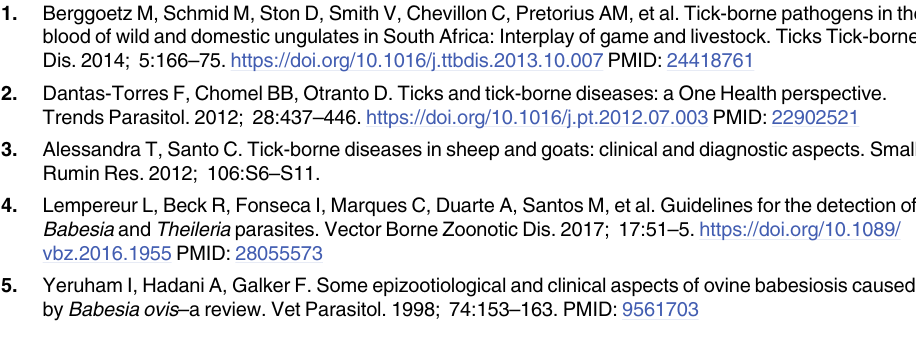
S1 Fig. Map of Iran showing sampling sites in Sistan and Baluchestan province, Iran.